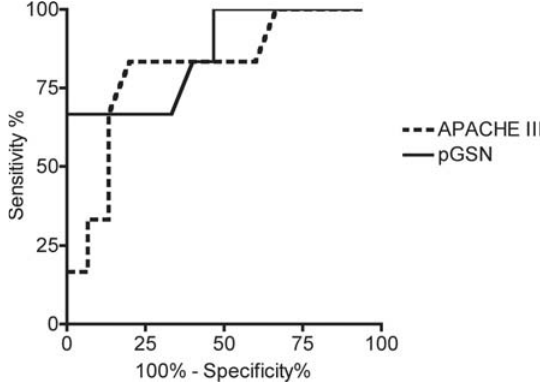
Figure 3. ROC analysis of pGSN and APACHE III. Receiver operating curves of pGSN levels (solid line) and APACHE III scores (dotted line) identifying 28-day mortality in septic patients are generated. Area under curve is 0.86 for pGSN (95% confidence interval of 0.68–1.05, p=0.011), and 0.81 for APACHE III (95% confidence interval of 0.60–1.02, p=0.03. A pGSN level cutoff of , 113.6 mg/L yields a 66.7% sensitivity and 93.3% specificity with a likelihood ratio of